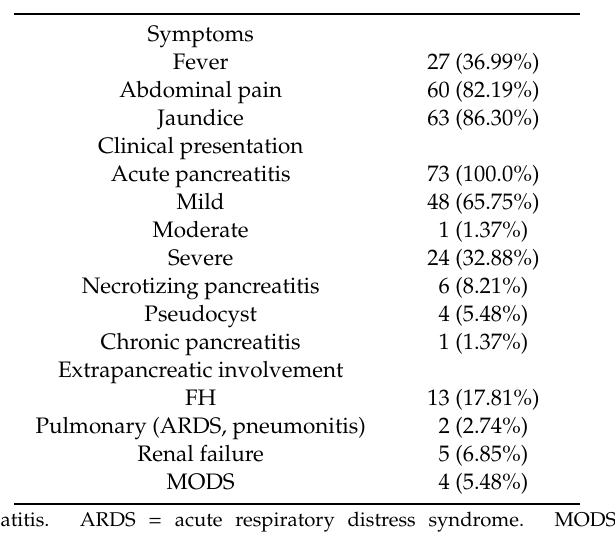
Table 2. Clinical characteristics of 73 patients with viral hepatitis diagnosed with pancreatitis.